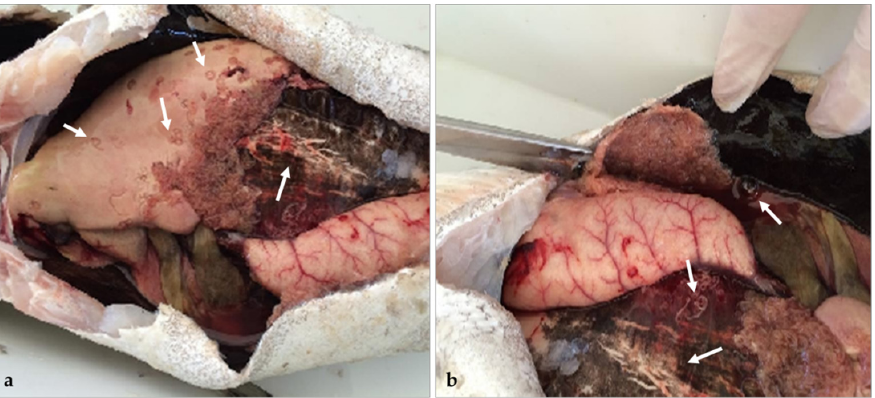
Figure 2. (a,b) Merluccius merluccius heavily infected with Anisakis larvae. The larvae were found in the liver and visceral organs